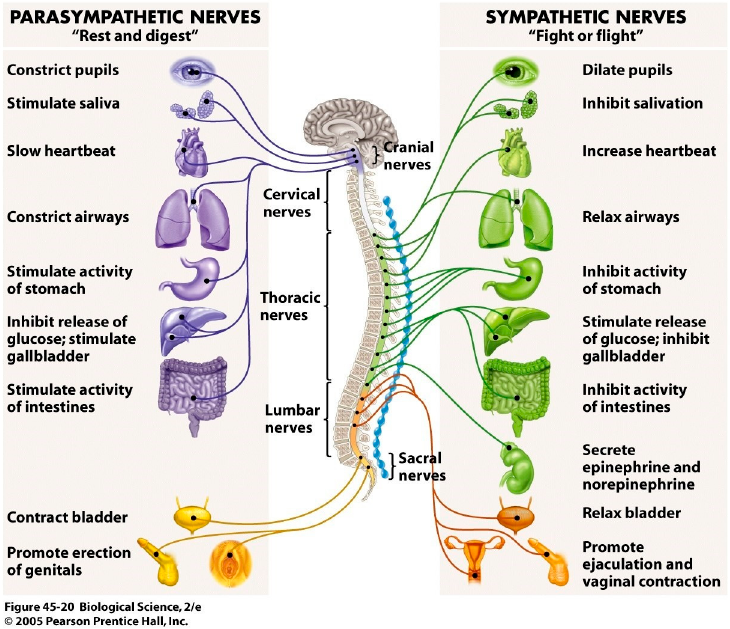
Figure A1. The Autonomic Nervous System.